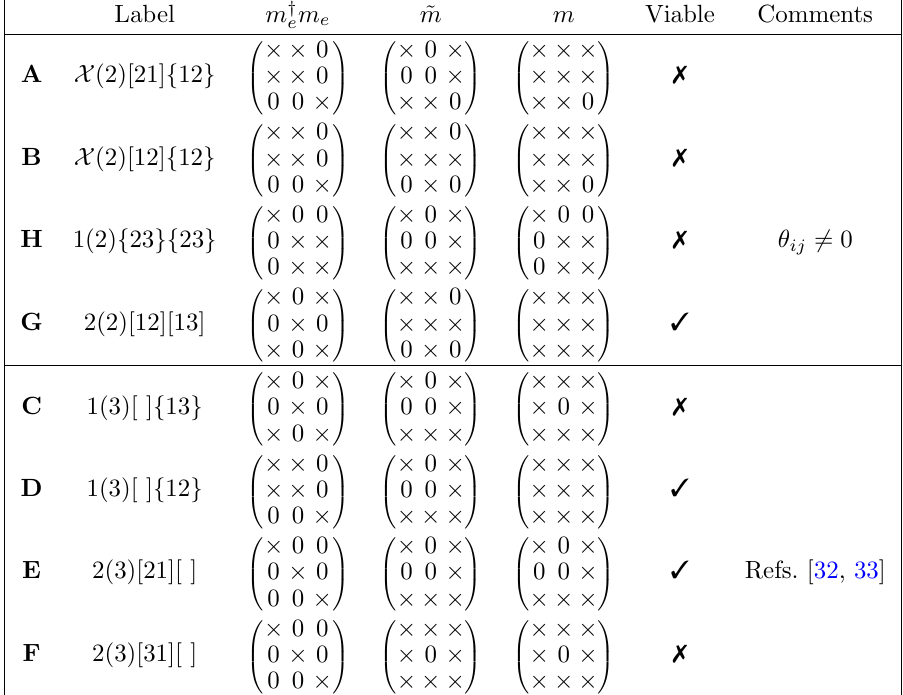
Table 2 . Possible matrix structures for the viable parameter assignments listed in table 1. In the (cid:12)rst two lines X = jX 1 ; 2 j is left unspeci(cid:12)ed, meaning that the same textures are obtained in both cases X = 1 and X = 2. Structures of type H yield some vanishing mixing, and are thus ruled out by the condition (cid:18) ij 6 = 0 as is indicated in the last column. Structures of type E with two vanishing parameters can yield viable models. This type of matrices has been already thoroughly analysed in the literature [32{41], and hence are omitted from our